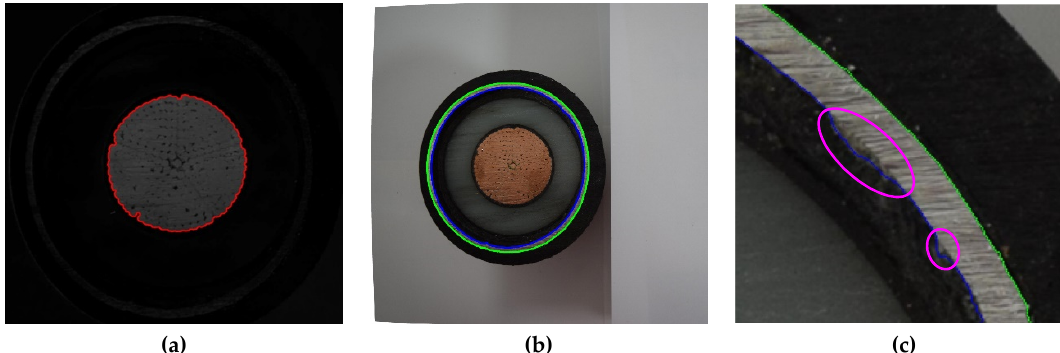
Figure 17. Coarse contour extraction of metal layers. ( a ) Extracted rC 12 plotted with red dots on U (cid:48) Figure 17 . Coarse contour extraction of metal layers. (a) Extracted (cid:1870)(cid:1829) (cid:2869)(cid:2870) plotted with red dots on (cid:1847) (cid:4593) Figure 17 . Coarse contour extraction of metal layers. (a) Extracted 𝑟𝐶 12 plotted with red dots on 𝑈 ′ component; ( b ) Extracted rC 67 in blue dots and rC 78 in green dots; ( c ) Partial enlargement of ( b ), in component; (b) Extracted (cid:1870)(cid:1829) (cid:2874)(cid:2875) in blue dots and (cid:1870)(cid:1829) (cid:2875)(cid:2876) in green dots; (c) Partial enlargement of (b), in component; (b) Extracted 𝑟𝐶 67 in blue dots and 𝑟𝐶 78 in green dots; (c) Partial enlargement of (b), in which deviations are circled. which deviations are circled. which deviations are circled.